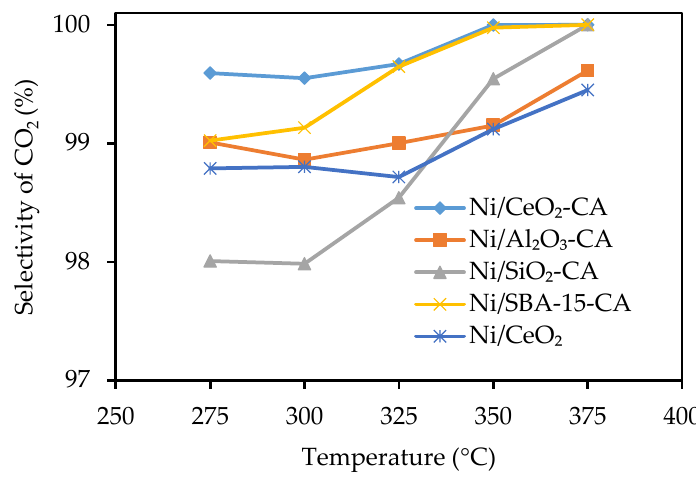
Figure 7. Effect of temperature on CH 4 selectivity over different catalysts:. H 2 :CO 2 :CH 4 = 4:1:1, WHSV = 45 L/h g catalyst and pressure = 12.5 bar.